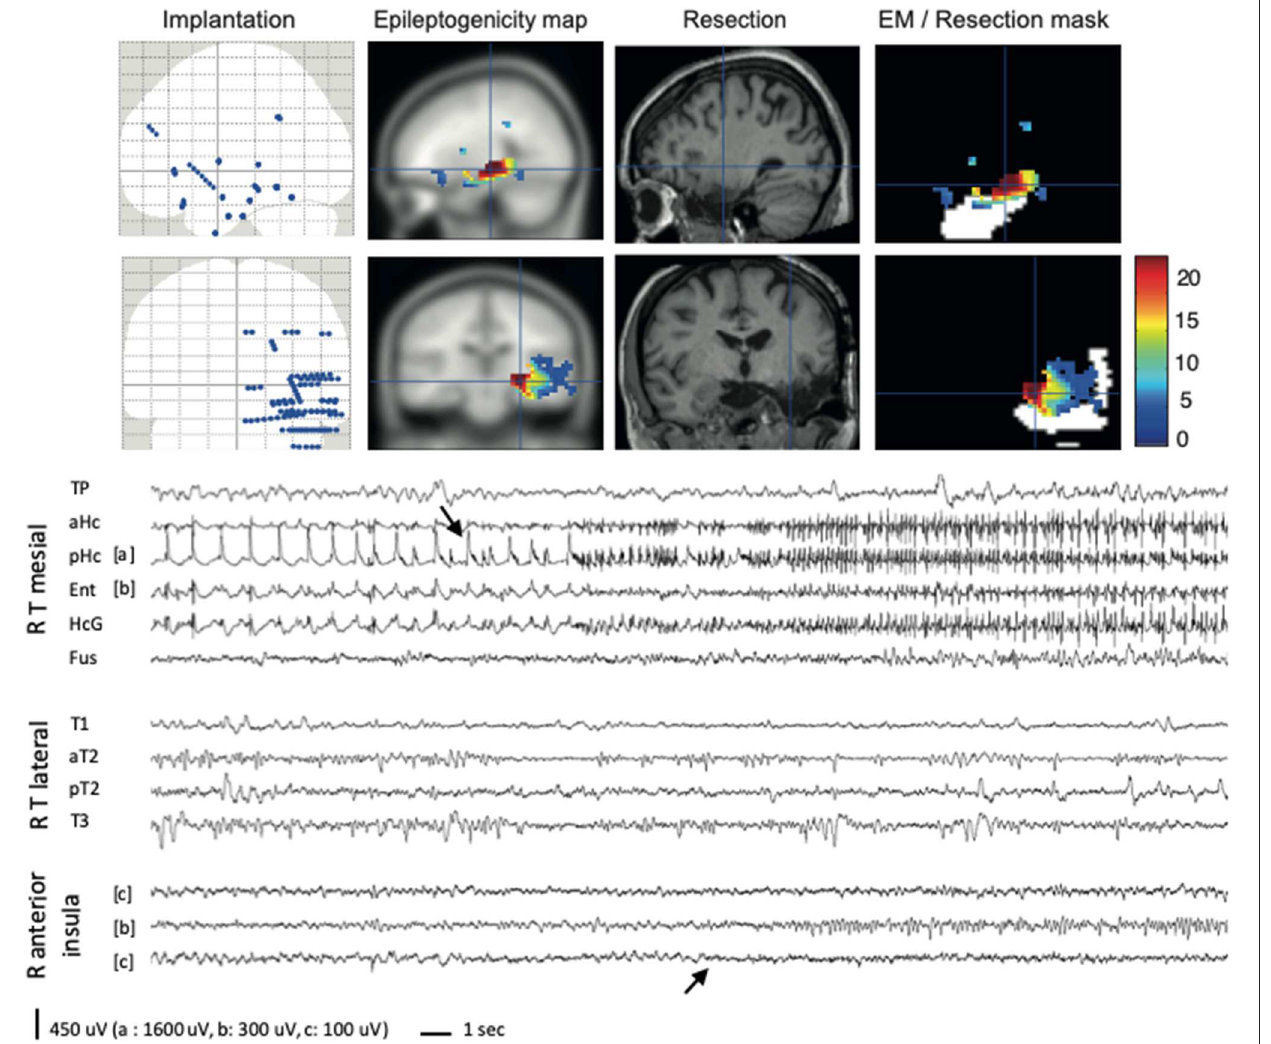
FIGURE 1 | EM method applied to a temporal epilepsy case (#4). For this patient, the semiology pointed to a right temporo-insular involvement, in association with a hippocampal sclerosis. Right temporal and perisylvian implantation was performed. The only seizure recorded started in the hippocampus (first arrow), with an early but discrete visual involvement of the insular cortex (second arrow). EM retrospectively confirmed the hippocampal involvement, but also enhanced the early insular involvement during the seizure. The resection (planned on visual analysis) was limited to the mesial temporal cortex, and FASTectomy ratio was very low (4%). Immediately after surgery, the patient started to have seizures pointing to the right insula (left tingling, throat constriction). The colorbar indicates the epileptogenicity values. Resection mask is in white. R, right; T, temporal; TP, temporal pole; aHc/pHc, anterior/posterior hippocampus; Ent, entorhinal cortex; HcG, parahippocampal gyrus; Fus, fusiform gyrus; T1/T2/T3, first/second/third temporal